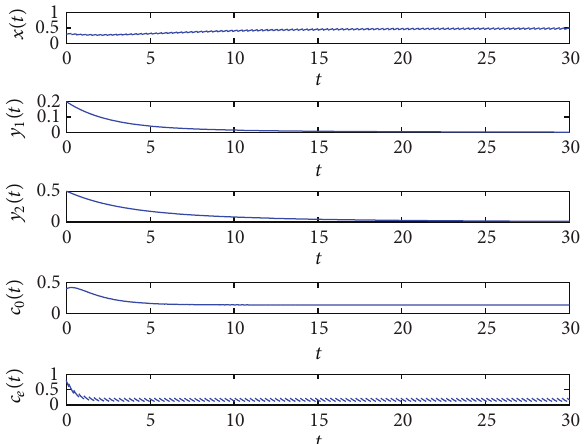
Figure 4: Time series of system (2) with parameters 𝛽 = 0.9 , 𝐾 = 0.8 , 𝑞 = 0.8 , 𝑑 = 0.4 , 𝜏 = 0.5 , 𝜆 = 0.8 , 𝛾 = 0.3 , 𝑏 = 0.1 , 𝑘 = = 0.2 , 𝑓 = 0.1 , 𝛿 = 0.5 , 𝛼 = 0.2 , ℎ = 2 , 𝑔 = 0.2 , 𝑚 = 0.5 , 𝑓 2 1 0.4 , and 𝑇 = 1